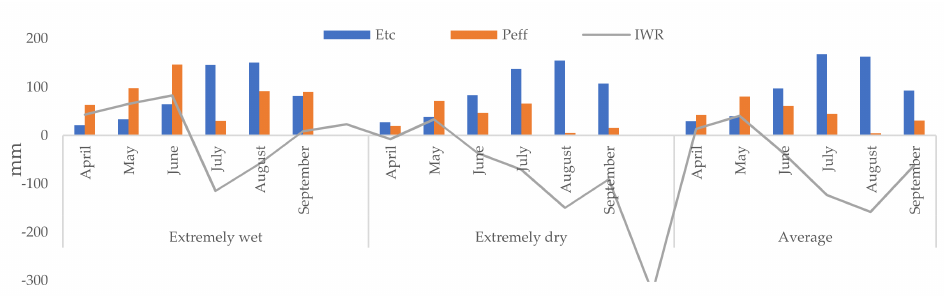
Figure 5. Crop water requirements (ETc), effective rainfall (Peff), and irrigation water requirements (IWR) in different weather